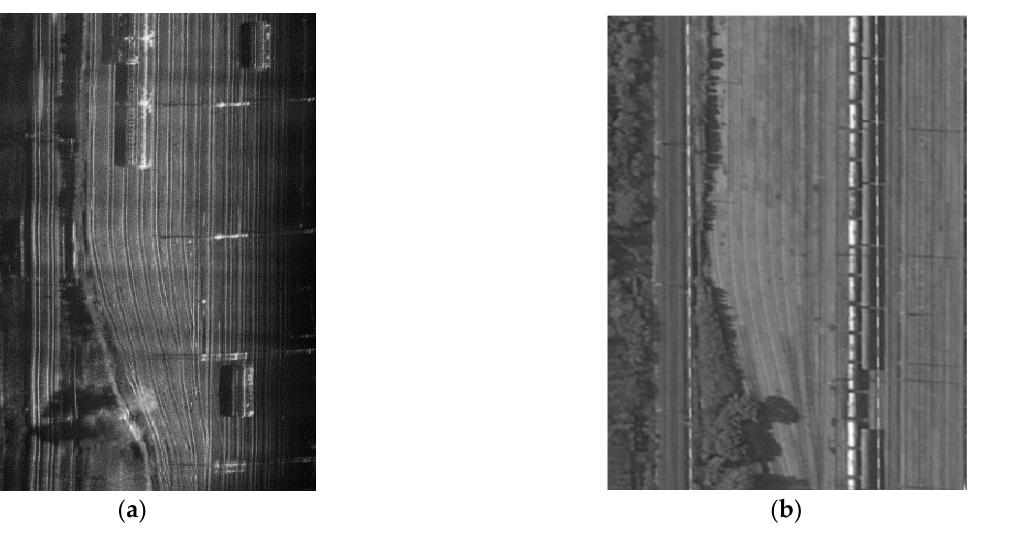
Figure 14. Comparison between APA mini-SAR image and the optical image. ( a ) W-Band active phased array miniaturized SAR image. ( b ) The optical image from Google Maps.